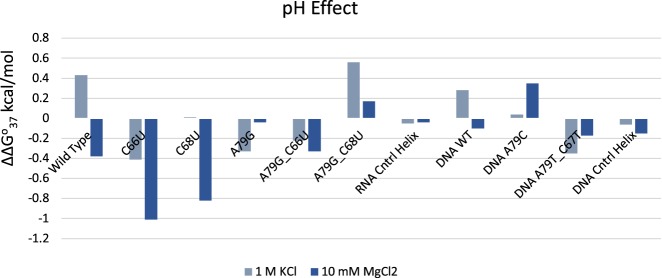
Effect of pH on construct stability. The ΔΔG° values (in kcal/mol) are the difference between ΔG°37 at pH 5.5 and pH 7.5. Positive values indicate gain in stability at pH 5.5 over pH 7.5.